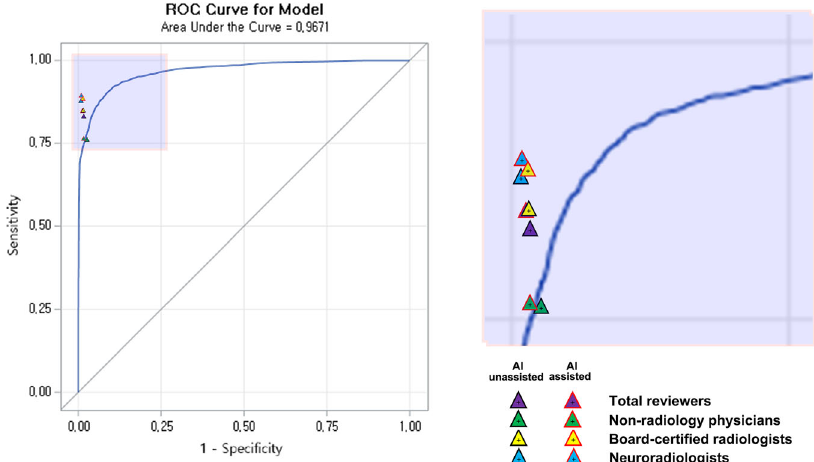
Fig. 2 Diagnostic performance of reviewers in terms of basic ROC curves for slice-wise AI standalone performance. In the reader assessment study, the AI-assisted group demonstrated a signi fi cantly higher diagnostic accuracy in detecting AIH than that of the AI- unassisted group in the slice-wise analysis (0.9581 [95% CI: 0.9569, 0.9592] vs. 0.9522 [95% CI: 0.9509, 0.9534], p < 0.0001). Based on the subgroup analysis, non-radiologist physicians and board-certi fi ed radiologists demonstrated a signi fi cant improvement in diagnostic accuracy with AI assistance relative to that for the AI-unassisted group (for non-radiologist physicians: 0.9393 [95% CI: 0.9369, 0.9417] vs. 0.9306 [95% CI: 0.9280, 0.9332], with a difference of 0.87 [95% CI: 0.52, 1.22], p < 0.0001, for board-certi fi ed radiologists 0.9632 [95% CI: 0.9623, 0.9661] vs. 0.9567 [95% CI: 0.9546, 0.9587], with a difference of 0.75 [95% CI: 0.48, 1.03], p < 0.0001). Note. ROC: receiver operating